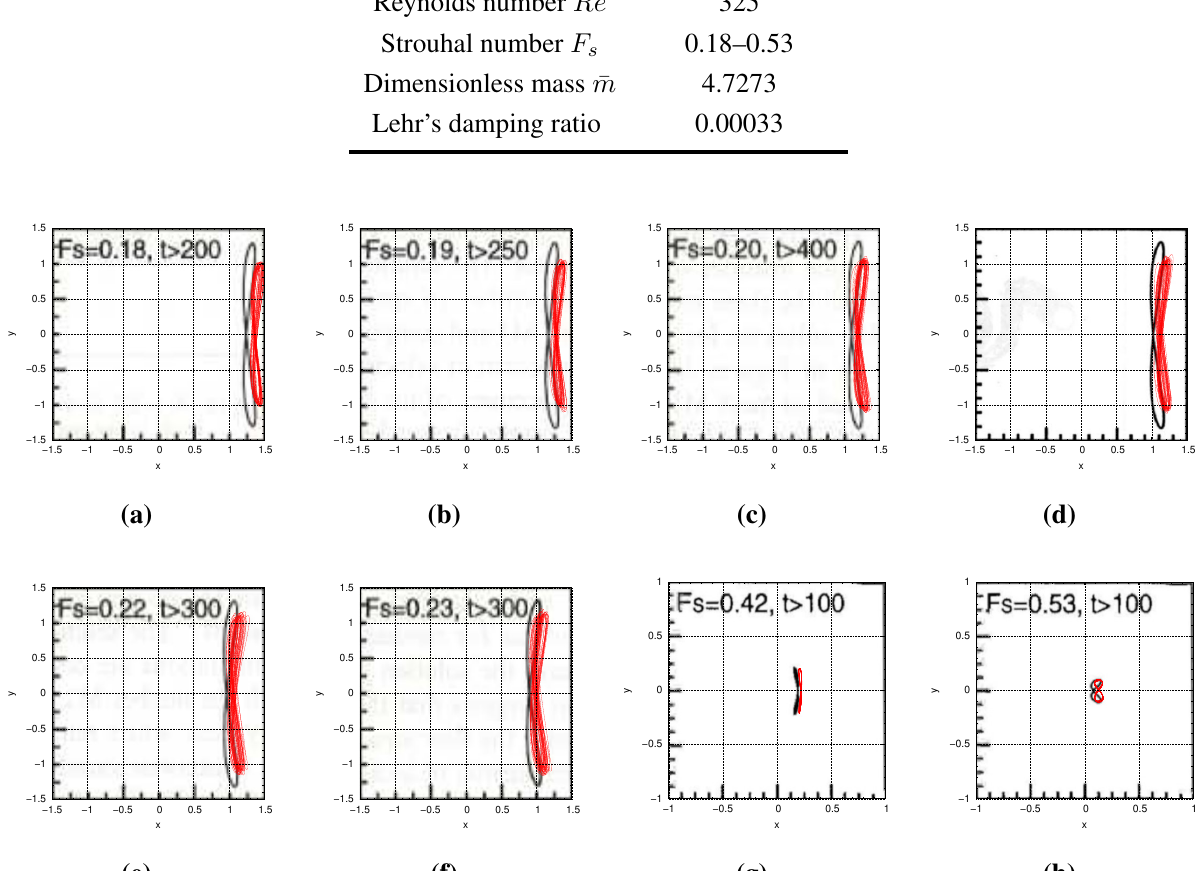
Figure 26. Results for the oscillating cylinder test case for varying Strouhal numbers F (red), in comparison to reference data of [53] (black). ( a ) F = 0 . 20 ; ( d ) F ( c ) F s